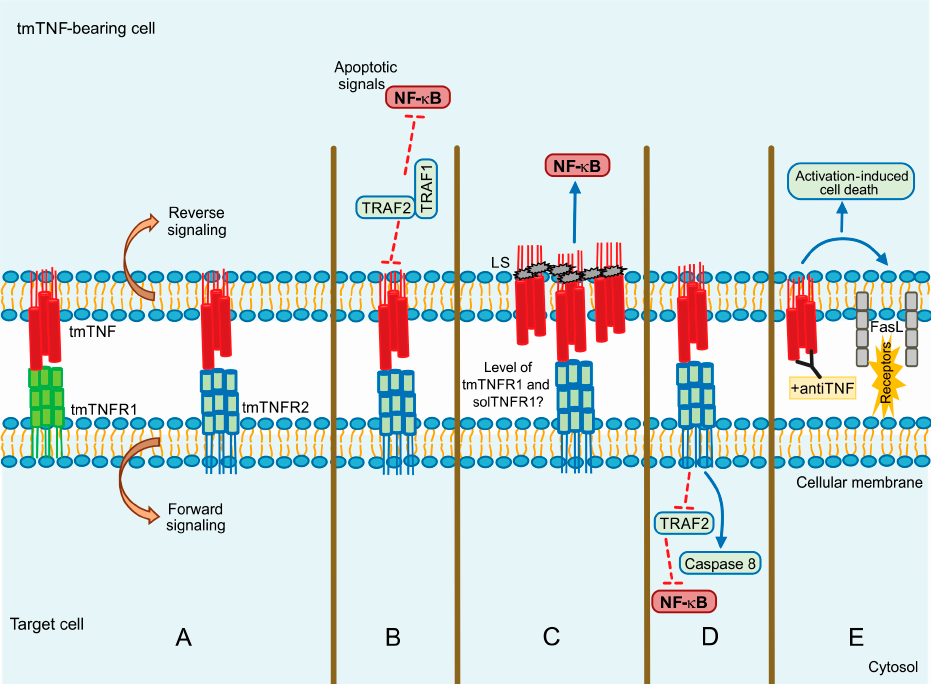
Figure 3. tmTNF signalling pathway. ( A ) Forward and reverse signalling; ( B ) Apoptotic signal by TRAF1 and TRAF2; ( C ) Direct NF-kB activation by LS (leader sequence) in tmTNF; ( D ) Actin involvement in tm-TNF transduction; ( E ) Activation Induced Cell Death (AICD) by upregulation of FASL (CD95L). Continuous blue lines: activation signalling. Dotted red lines: inhibition